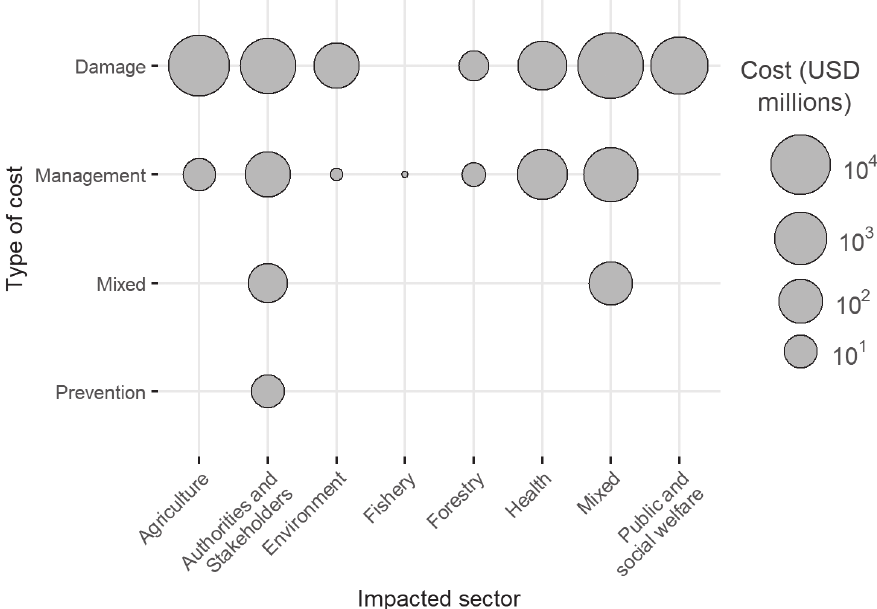
Figure 3. Cost of biological invasions shared amongst impacted sectors and type of costs in Central and South